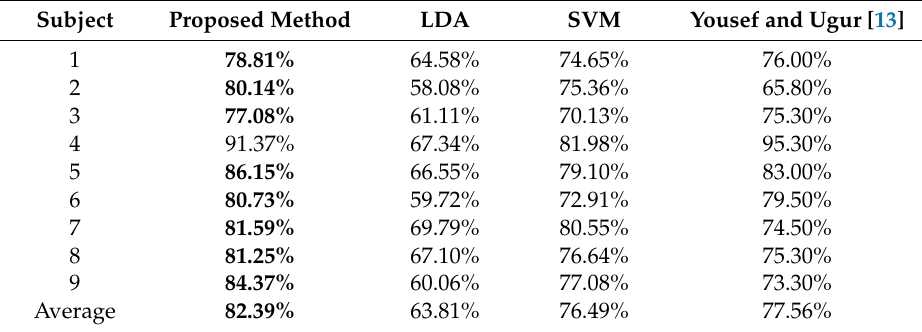
Table 3. Comparison of the classification accuracy (in %) with other machine learning techniques based on the dataset 2b obtained from the BCI competition